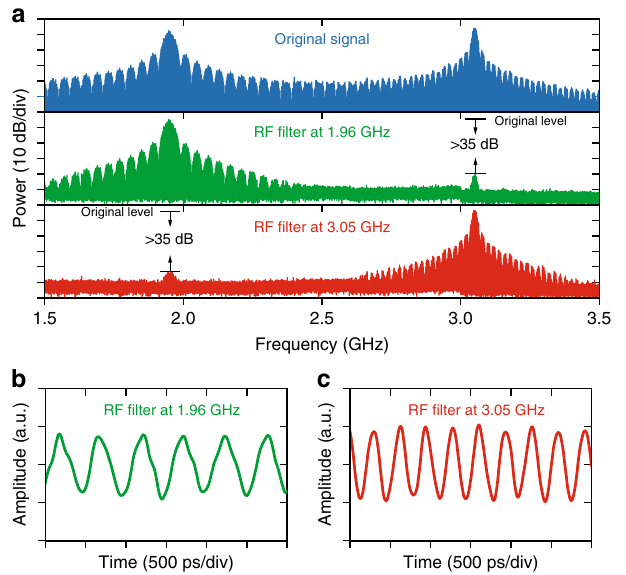
Fig. 4 Proof-of-concept experiment using TSM-based RF fi lters. Two PSK signals with 40 Mb/s modulation at 1.96 GHz and 20 Mb/s modulation at 3.05 GHz are fi ltered by the TSM-based RF fi lters centered at 1.96 and 3.05 GHz, respectively. a From top to bottom: electrical spectra of original microwave signal, signal after 1.96 GHz fi lter, and signal after 3.05 GHz fi lter. b Waveform after 1.96 GHz fi lter. c Waveform after 3.05 GHz fi